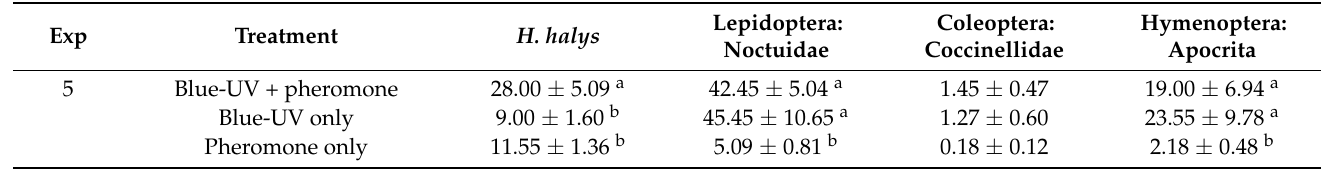
Table 4. Captures (mean ± SE) of H. halys and other main groups in a standard or simplified multimodal trap (Exp. 5). Means in the same column followed by different letters are significantly different according to linear model or linear mixed-effects models followed by multiple comparisons procedure (significance level α =